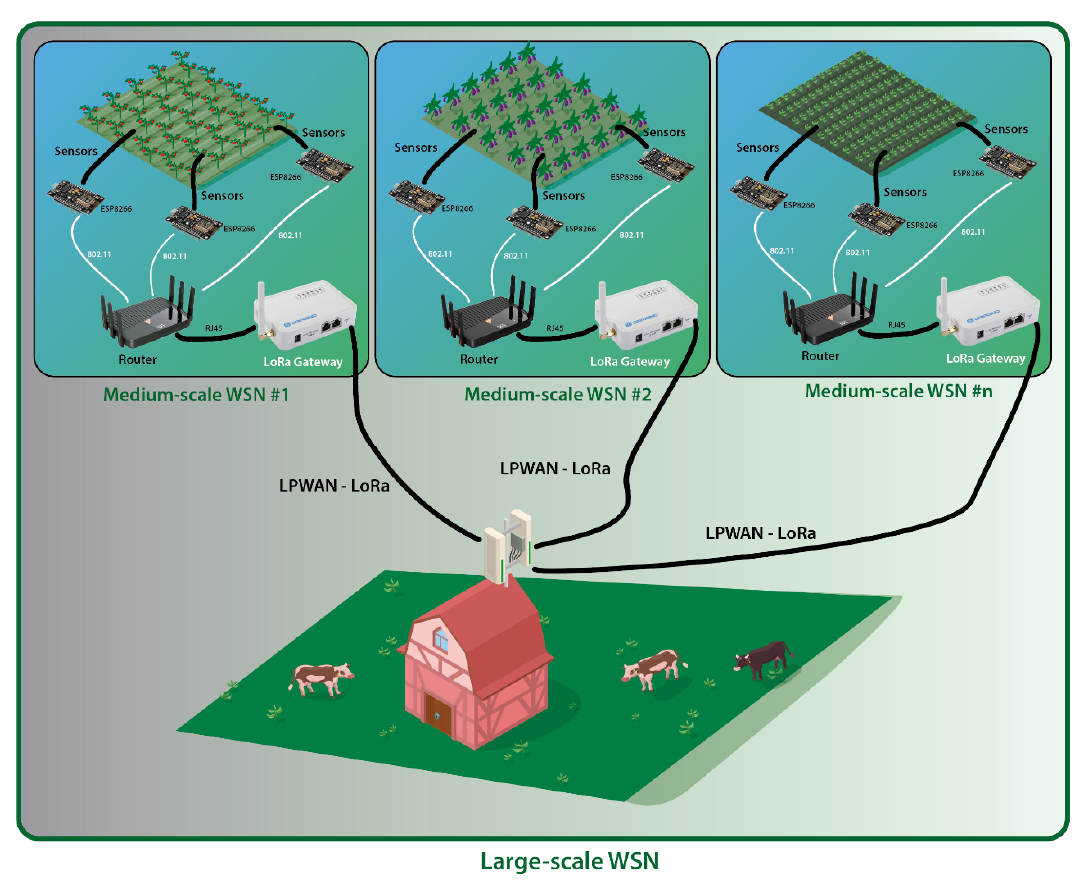
Figure 11. Mixed implementation of systems based on 802.11 and LPWAN wireless technology in medium and large scale. In the case of a potato crop in the Castilian plateau of the Iberian Peninsula, it would be possible to manage one hectare of crop with two medium-scale WSN (Wireless Sensor Network).